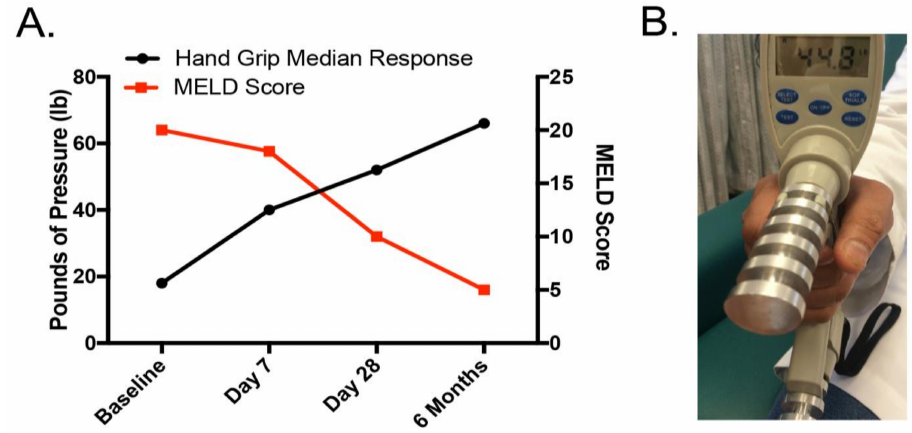
Figure 3. Time-course handgrip assessment in patient with moderate alcoholic hepatitis. ( A ) Correlation analysis between hand grip response and Model for End-Stage Liver Disease (MELD) score; ( B ) hand grip